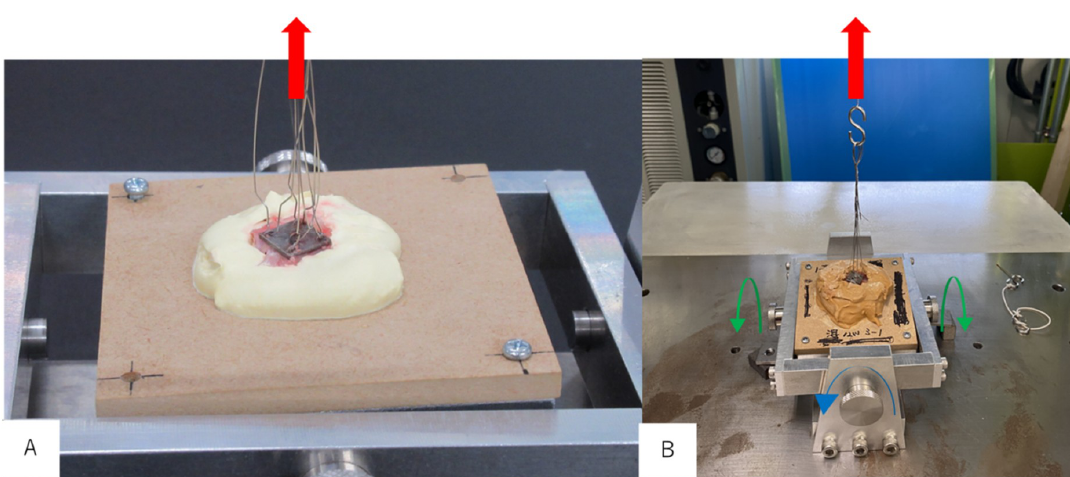
Figure 3. Evaluation of bone bonding. The bonding between the AM Ti plate and the cortical bone